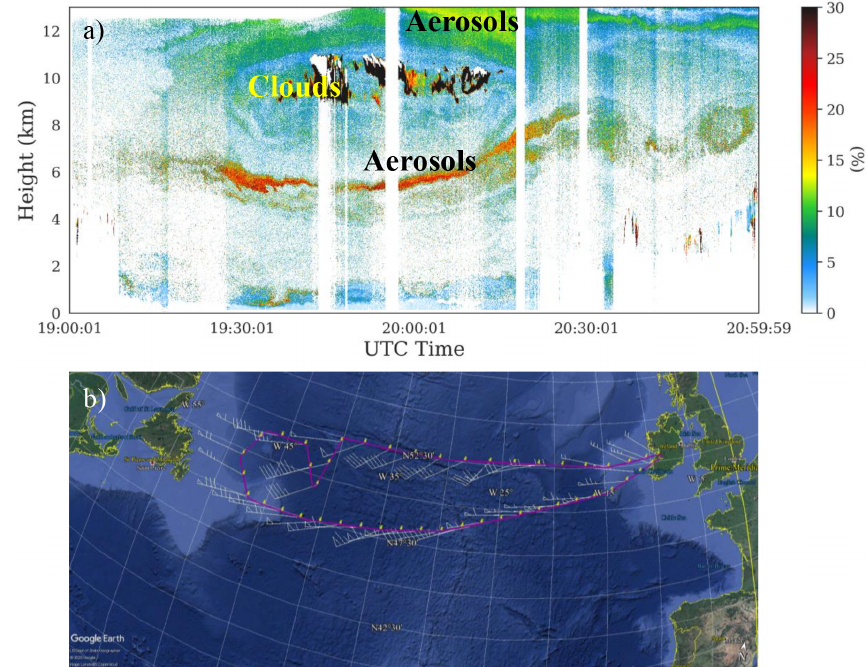
Figure 7. Time–height airborne lidar observations of the PLDR at 532nm (a) . Measurements were performed over the Atlantic Ocean, between 19:00 and 21:00UTC on 7 October 2017 by the DLR High Altitude and Long Range Research Aircraft (HALO) in the framework of the WISE mission. The track of the aircraft is shown in panel (b) , superimposed on the Google Earth map.